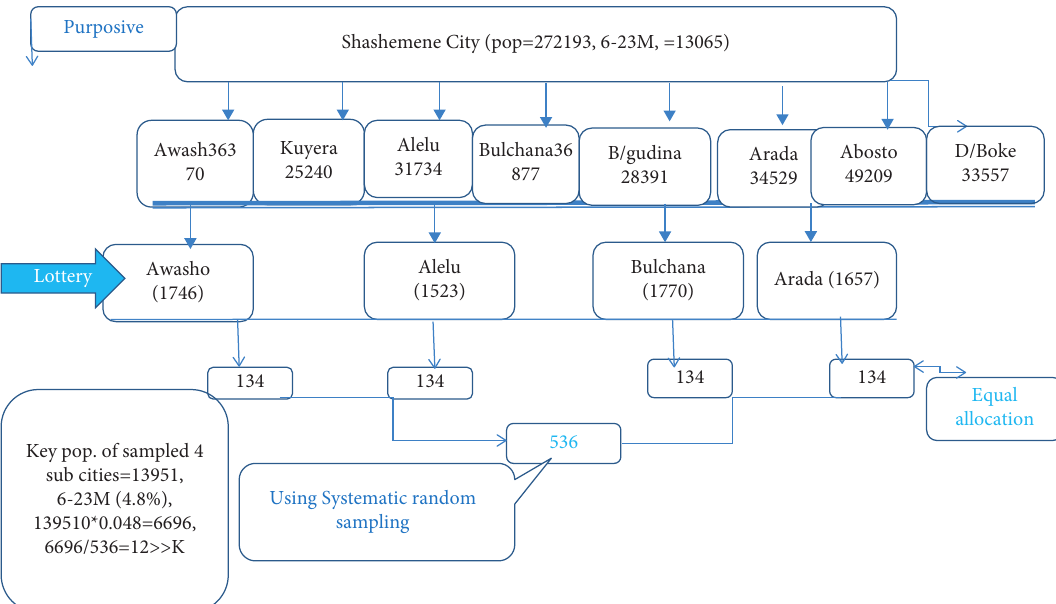
Figure 2: Diagrammatic presentation of the sampling scheme of the study participants among 6–23-month-old children in Shashemene city, Ethiopia, 2020. Pop: population, K : the